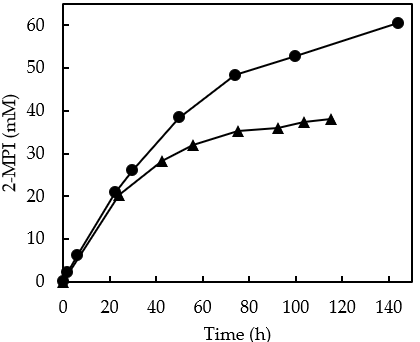
Figure 3. Synthesis of ( S )-2-MPI from N -pivaloyl-2-MPI by Arthrobacter sp. K5 cells (closed triangles) or recombinant cells (closed circles). The reactions were performed at 30 °C in 100 mM of potassium phosphate buffer (pH = 7.0) containing 100 mM of N -pivaloyl-2-MPI and whole cells derived from the culture broth equivalent to a five-fold amount of the reaction volume.